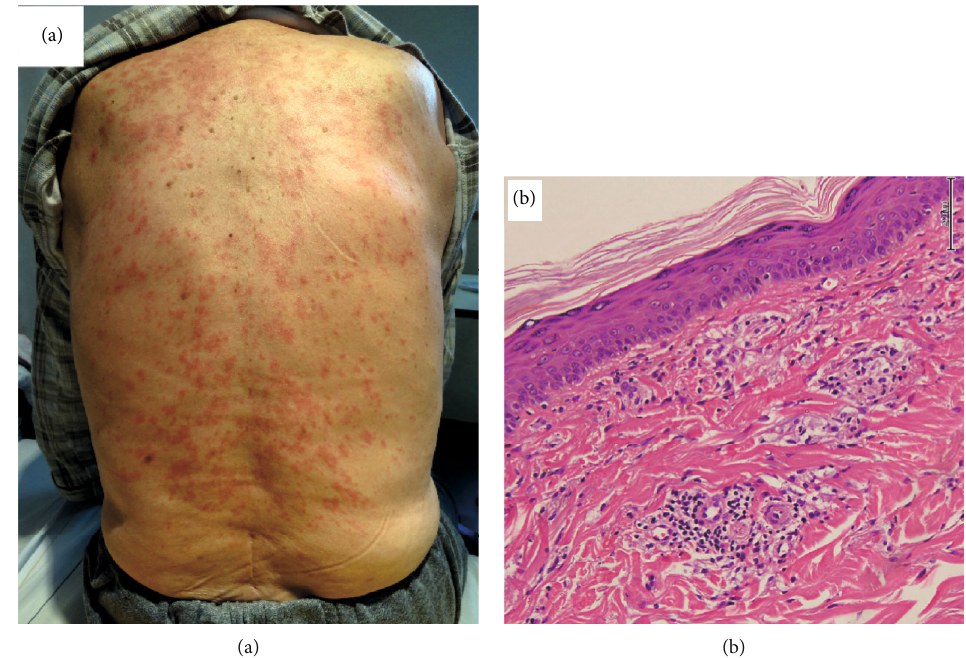
Figure 3: (a) There is a rash all over the body, mainly on the back. (b) Mild focal neutrophilic in fi ltration in the super fi cial dermis and mild to moderate perivascular lymphocytic in fi ltration. There are no vasculitis fi ndings. Haematoxylin and eosin stain.